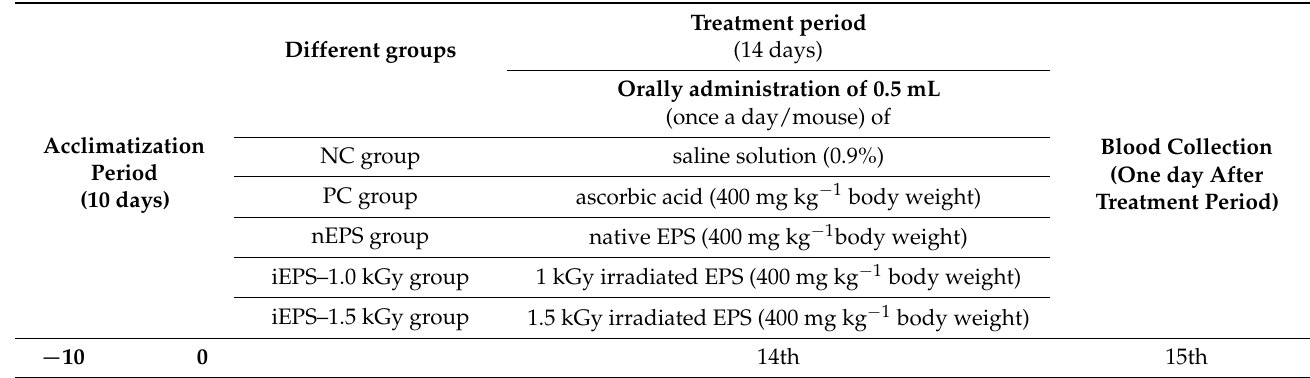
Table 1. Schematic representation of the experimental protocol for different groups. Animals were randomized into five groups ( n = 10 mice in each group; NC group: normal control group; PC group: positive control group; nEPS group: native EPS